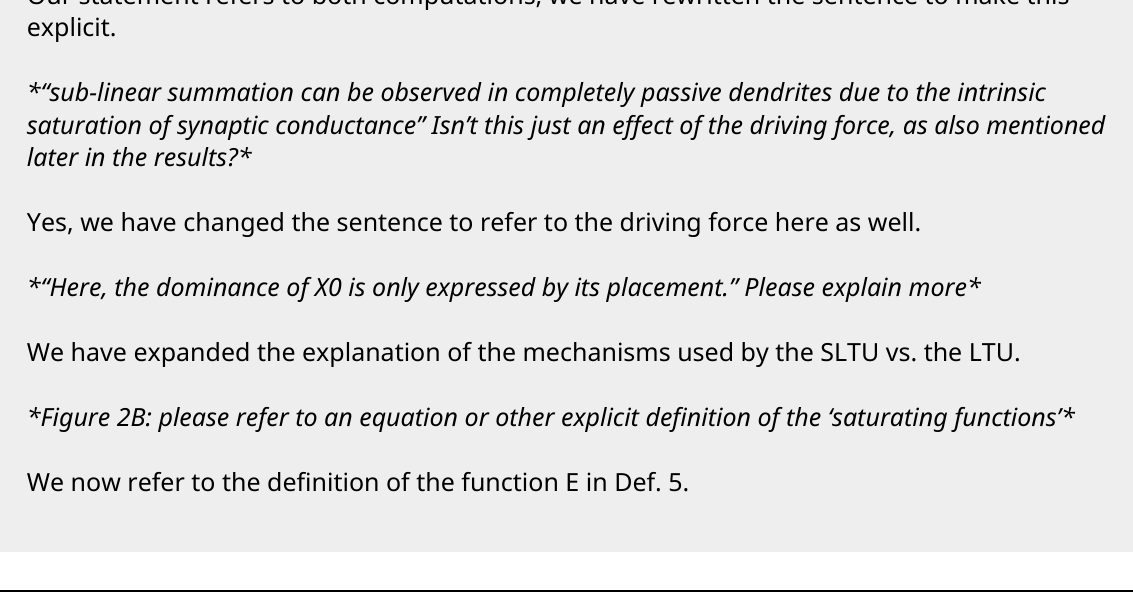
*Figure 2B: please refer to an equation or other explicit definition of the ‘saturating functions’* We now refer to the definition of the function E in Def.